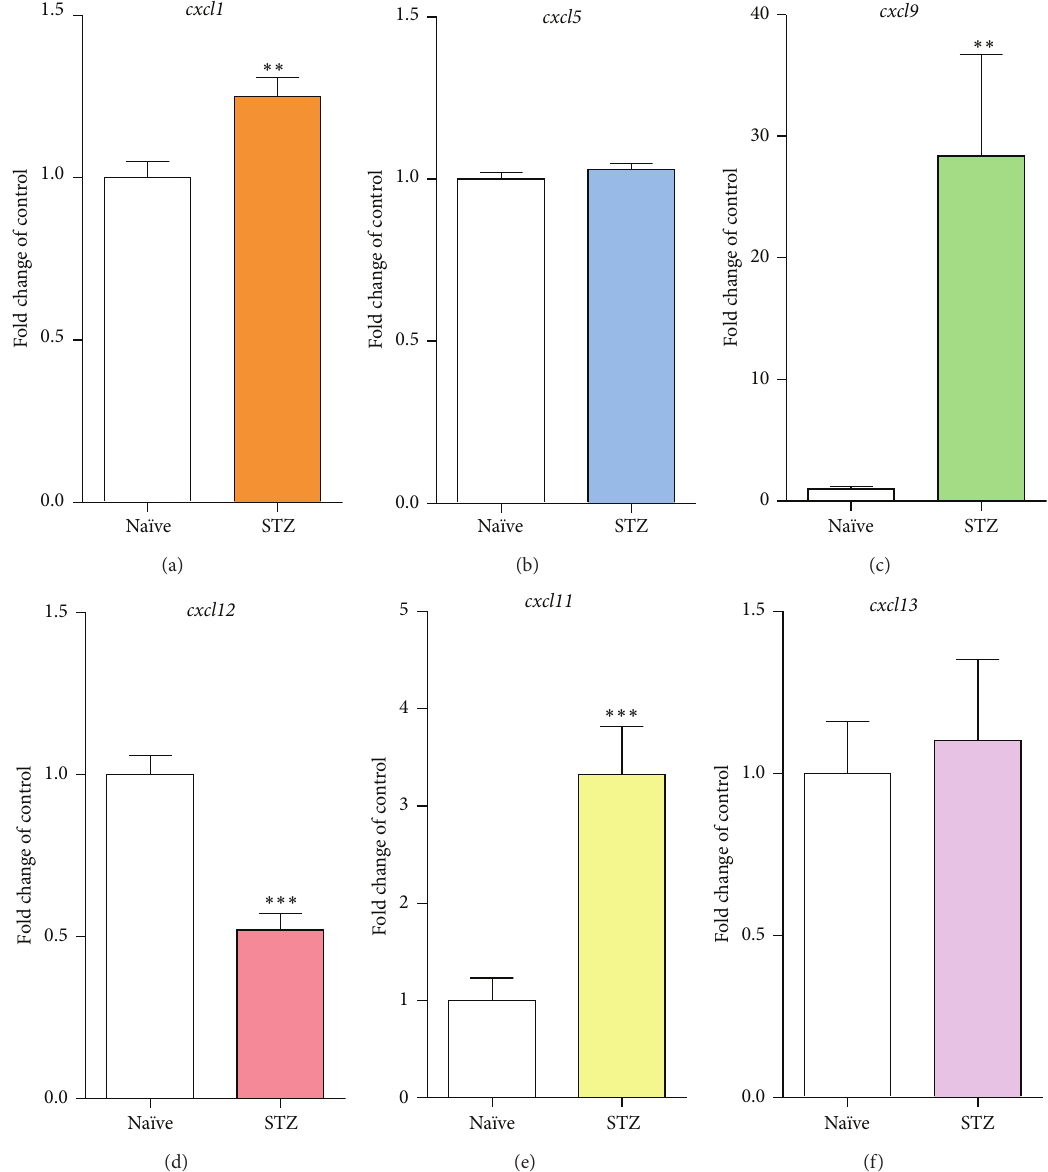
Figure 2: Changes in mRNA amount of chemokines from CXC subfamily after streptozotocin administration measured at day 7 in the mouse lumbar (L4–L6) part of the spinal cord. The qRT-PCR analysis of cxcl1 (a), cxcl5 (b), cxcl9 (c), cxcl11 (d), cxcl12 (e), and cxcl13 (f) expression in na¨ıve and streptozotocin- (STZ-) treated animals. The data are presented as fold change in the control (na¨ıve) ± S.E.M. (4–10 samples per group). The results were evaluated using Student’s 𝑡 -test. ∗∗ 𝑃 < 0.01 and ∗∗∗ 𝑃 < 0.001 indicate a significant difference compared with na¨ıve mice. STZ, streptozotocin-induced diabetic